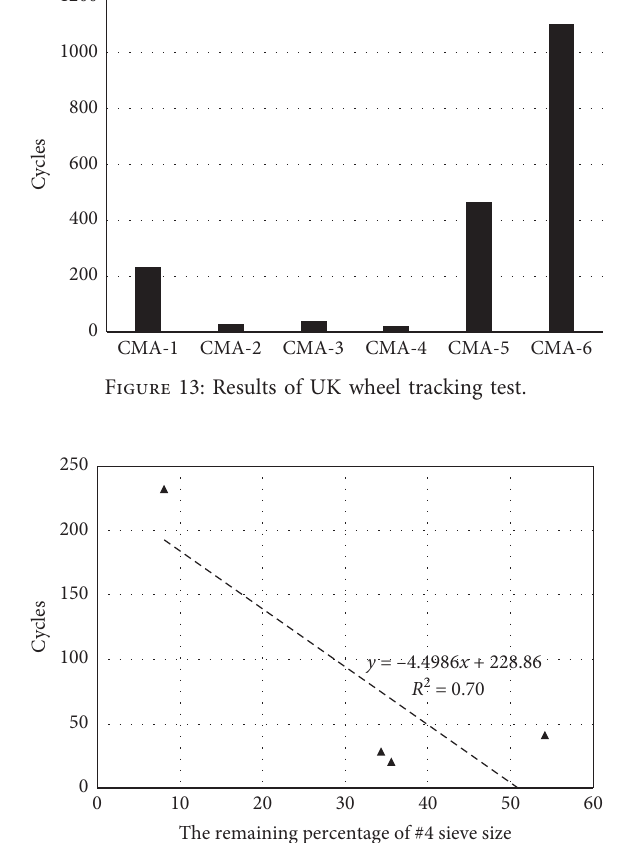
Figure 14: Correlation between cycles to rutting of 20mm and the proportion of coarse aggregate.